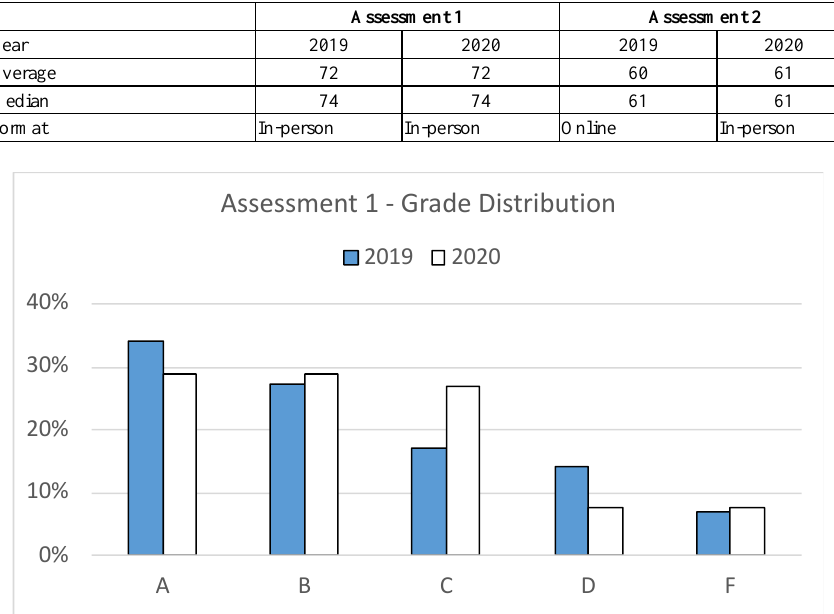
Table 1. Performance of students in the two assessments in Course-A in 2019 and 2020.